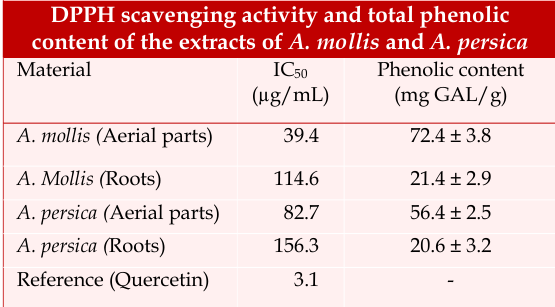
Effects of the test ointments of A. mollis and A.